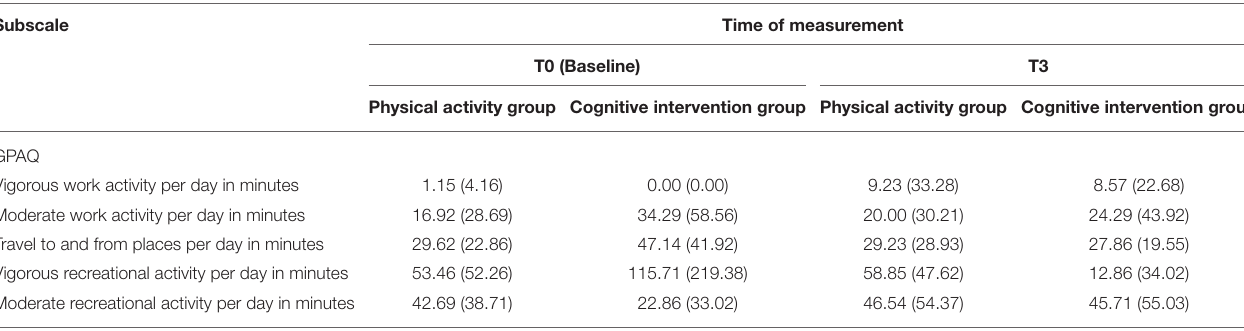
Subscale Time of measurement